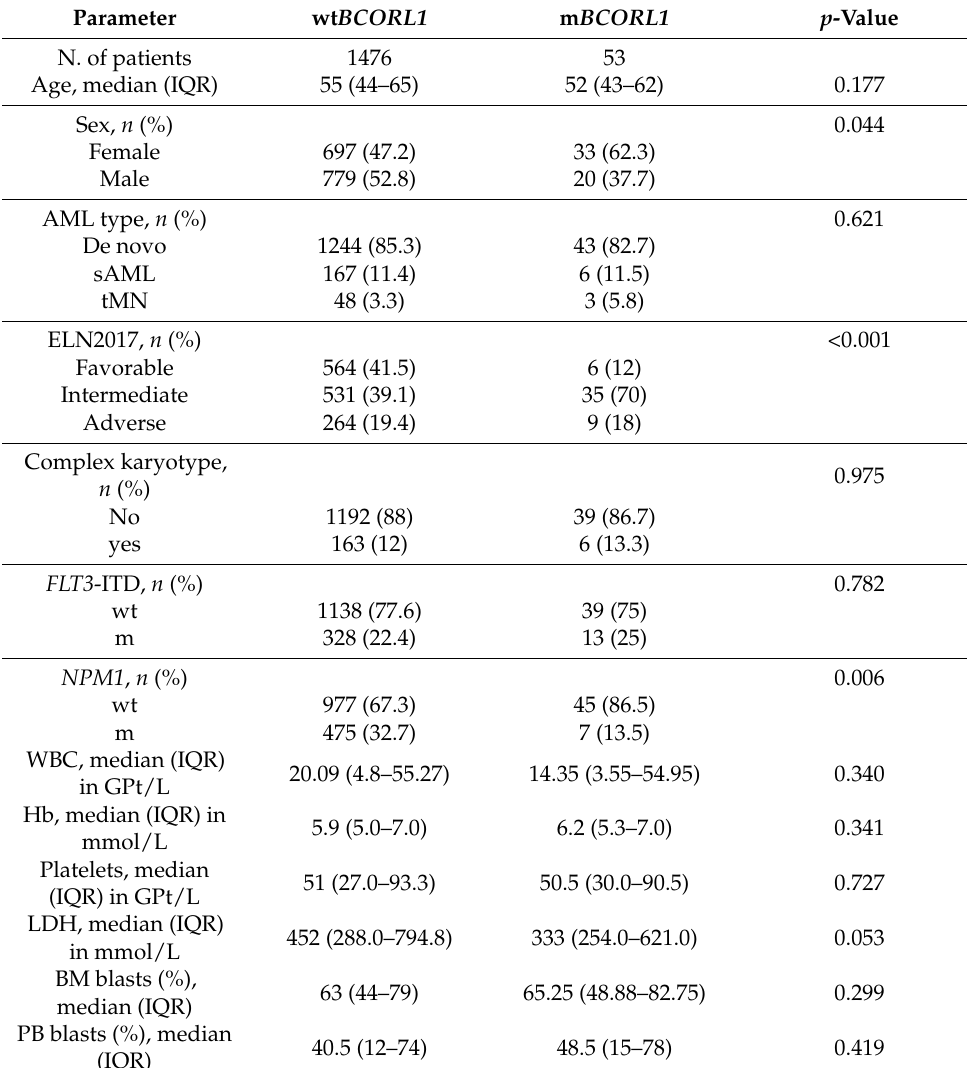
Table 2. Patient characteristics for m